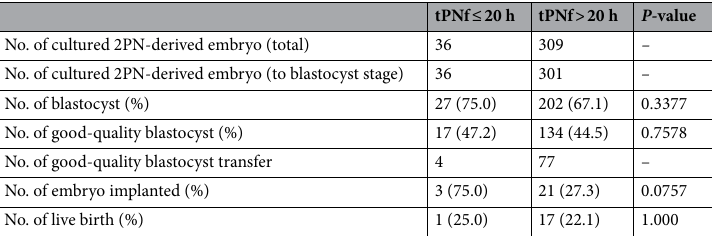
No. of cultured 2PN-derived embryo